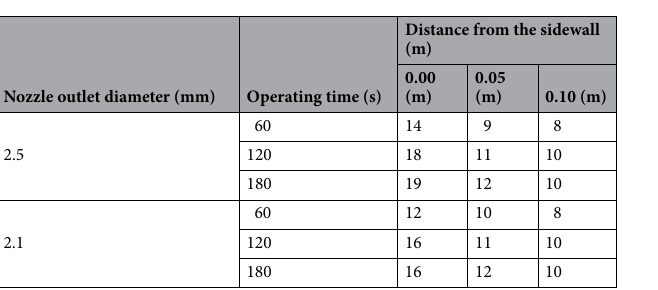
Nozzle outlet diameter